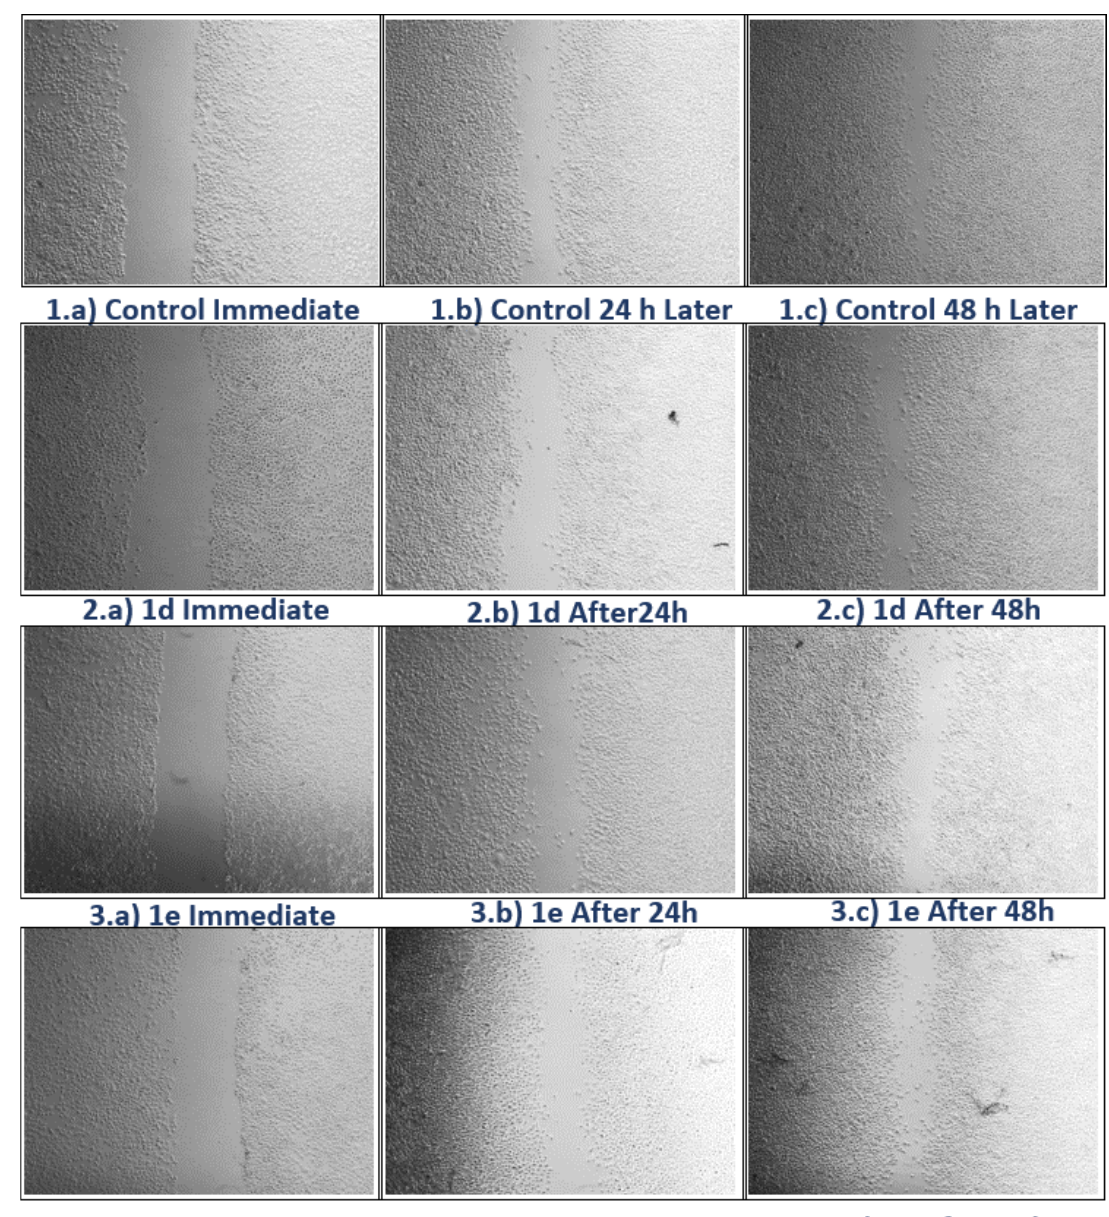
Figure 4. Analysis of cell migration by scratch assay for molecules 1d , 1e , and 2a on A549 cell line. Images were taken at 0 h, and 24 h, 48 h after incubation. Concentrations were 55 µM for 1d , 15 µM for 1e , and 15 µM for 2a . Control groups were treated with an equal amount of DMSO solvent.